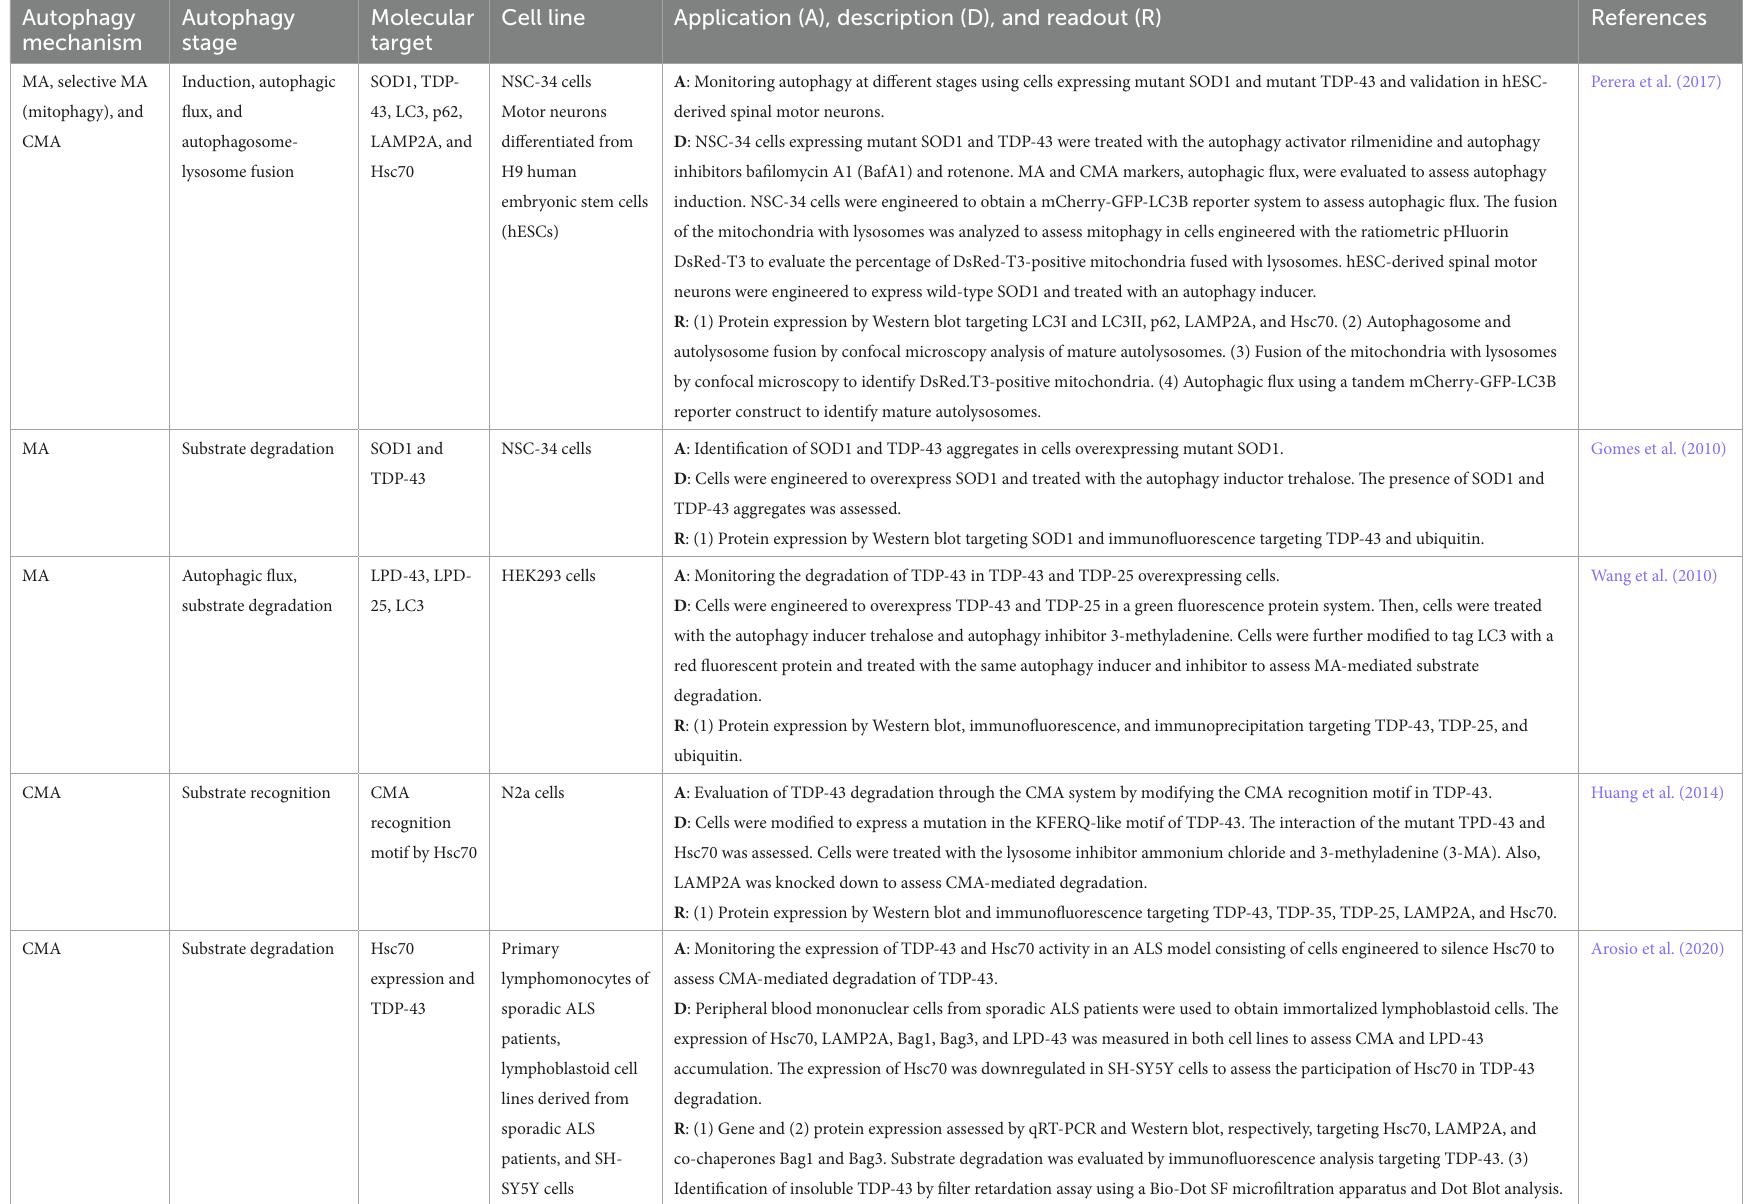
TABLE 3 In vitro autophagy methods in amyotrophic lateral sclerosis